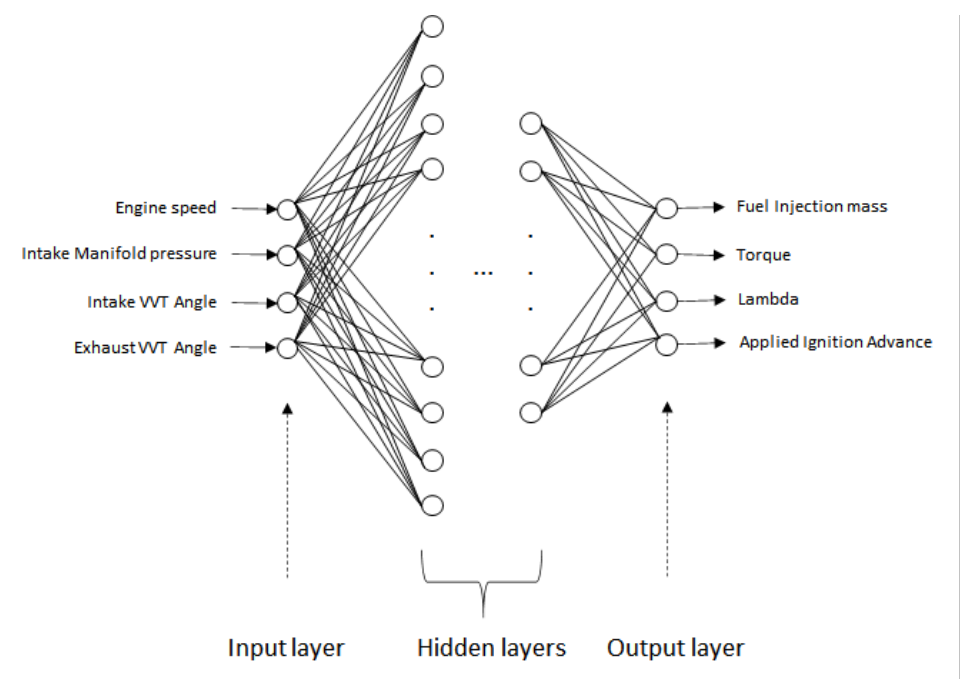
Figure 7. ANN architecture.